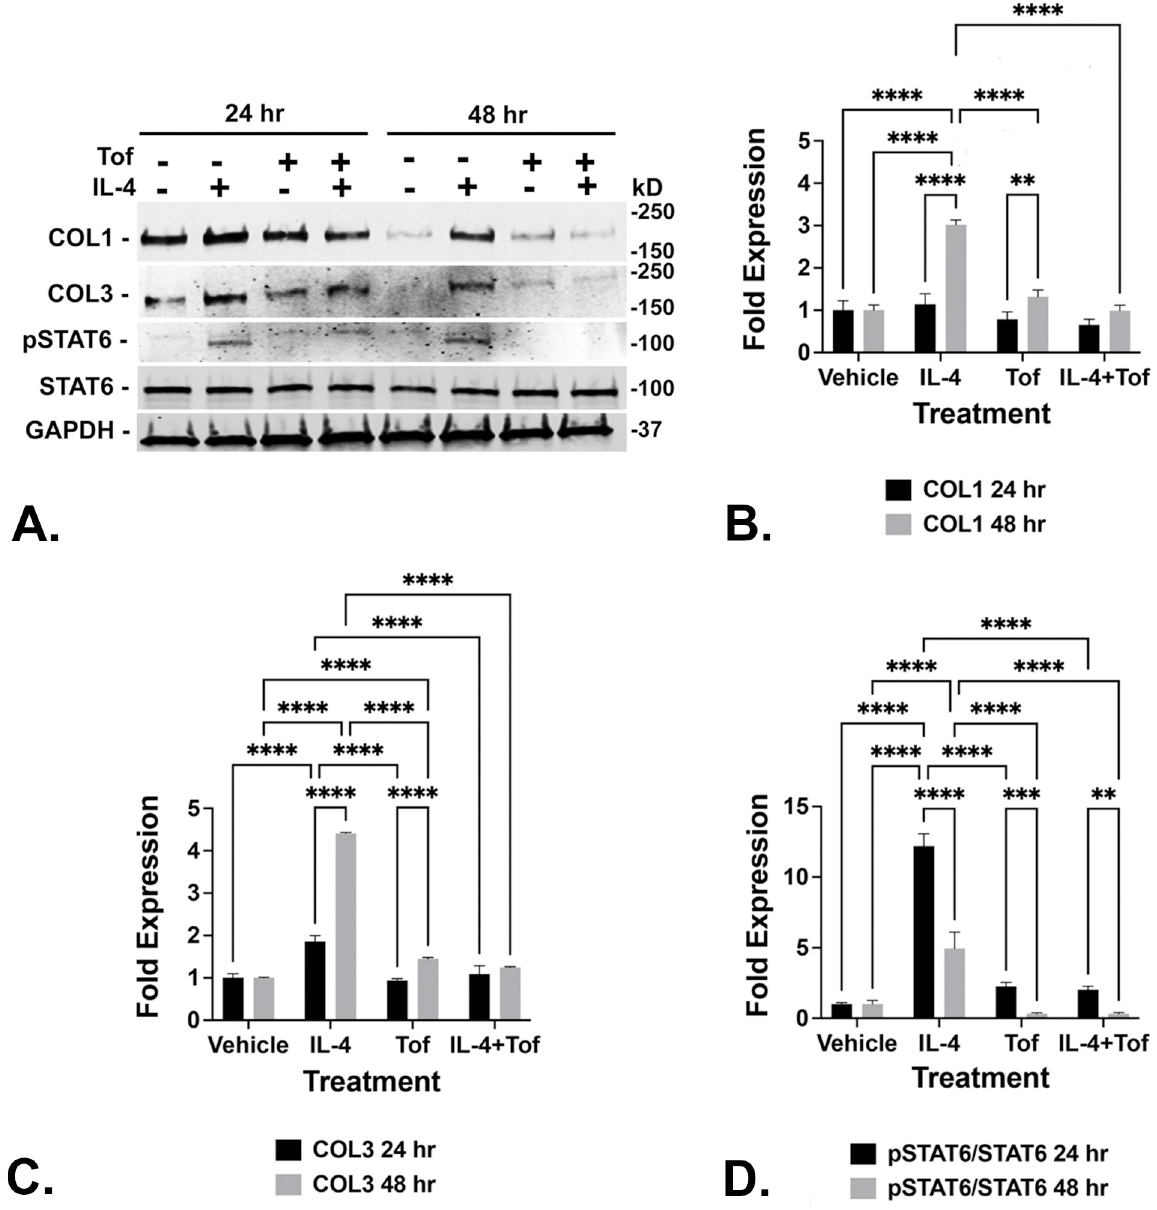
Fig 8. IL-4-mediated induction of collagen 1 and collagen 3 expression is coupled to JAK/STAT signaling. N1 immortalized human prostate fibroblasts were serum-starved for 48 hr then treated with vehicle or IL-4 (20ng/ml) with or without 2 hr pre-treatment with 5um tofacitinib, a JAK2/JAK3 inhibitor, and maintained in serum-free media for an additional 24 or 48 hr. IL-4 significantly induced expression of collagen I (COL1) and collagen 3 (COL3) concurrent with induction of STAT6 phosphorylation, all of which was repressed upon pre-treatment with tofactinib ( A ). Western blots shown in A are representative of 3 replicate experiments. Densitometric data from the replicate experiments is graphed in B (COL1), C (COL3 ), and D (pSTAT6/STAT6) (S8 Fig). Significant differences are indicated as � p < .05; �� p < .01; ��� p < .001; ���� p <